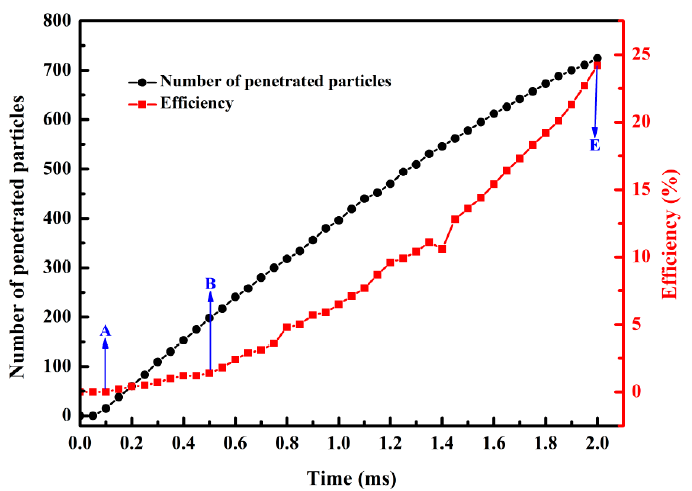
Figure 6. Curves of the cumulative number of penetrated particles and efficiency in capturing lignin particles with time.